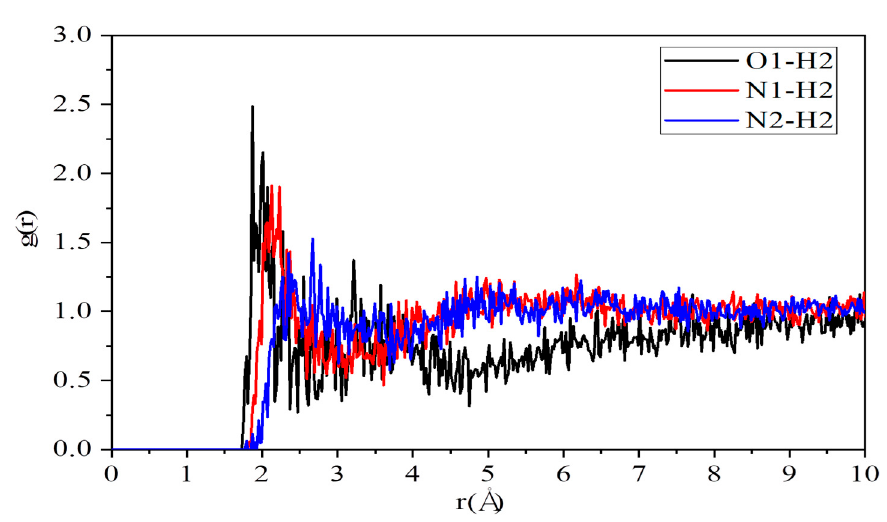
Figure 5. Intermolecular pair correlation functions of O1–H2 pair, N1–H2 pair, and N2–H2.